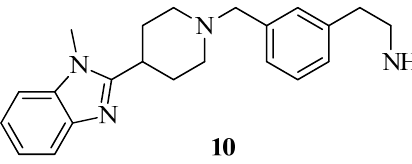
Figure 6. Benzimidazole derivative.